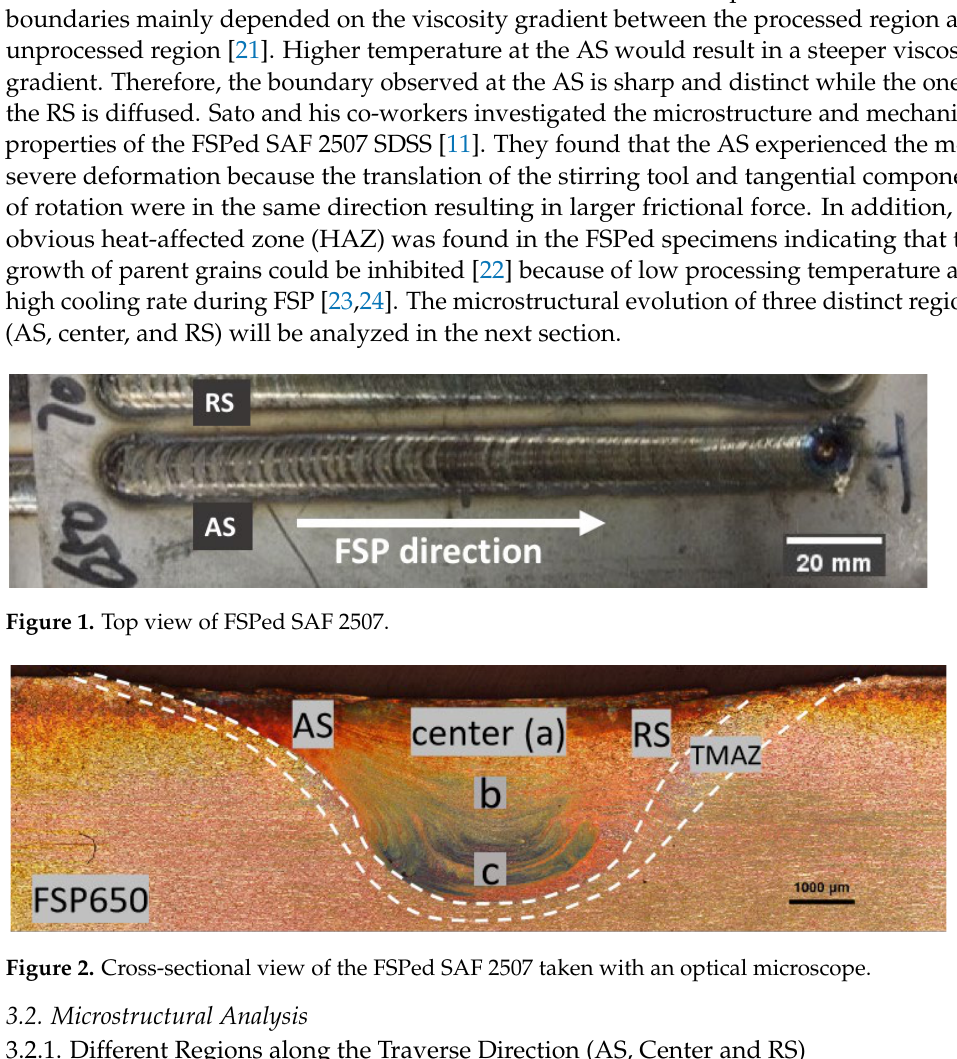
Figure 1. Top view of FSPed SAF 2507.